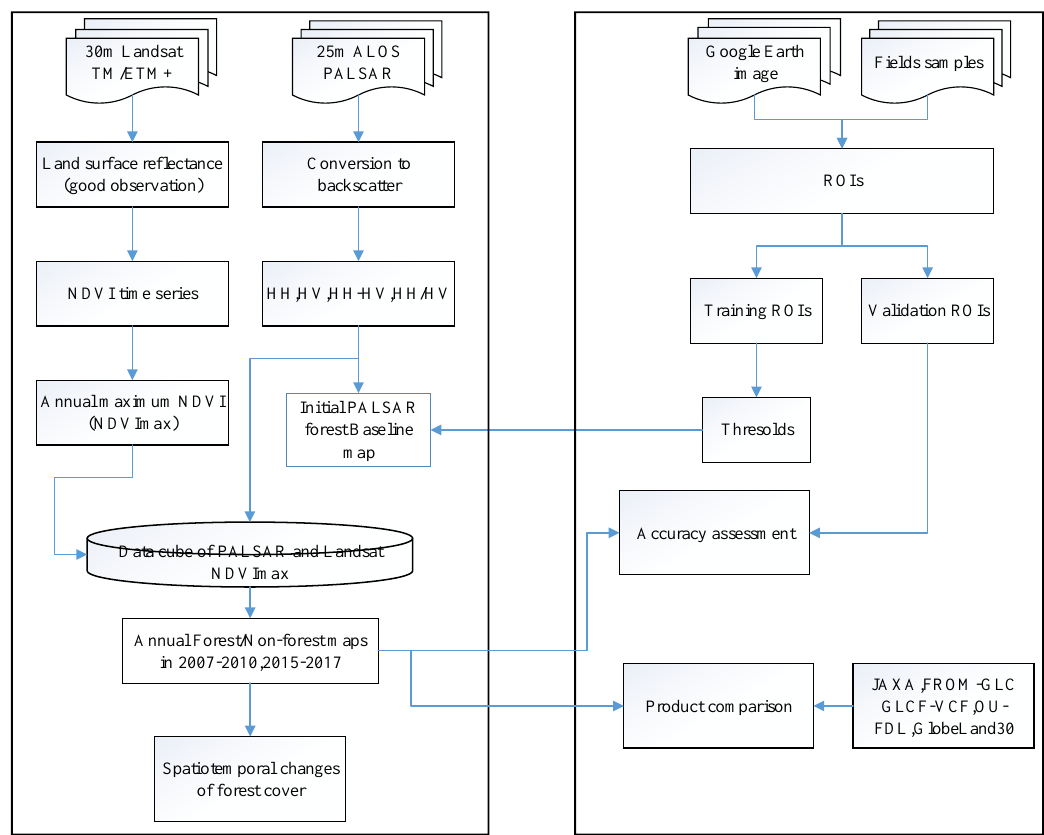
Figure 2. The workflow of forest mapping based on the ALOS PALSAR and Landsat TM/ETM+